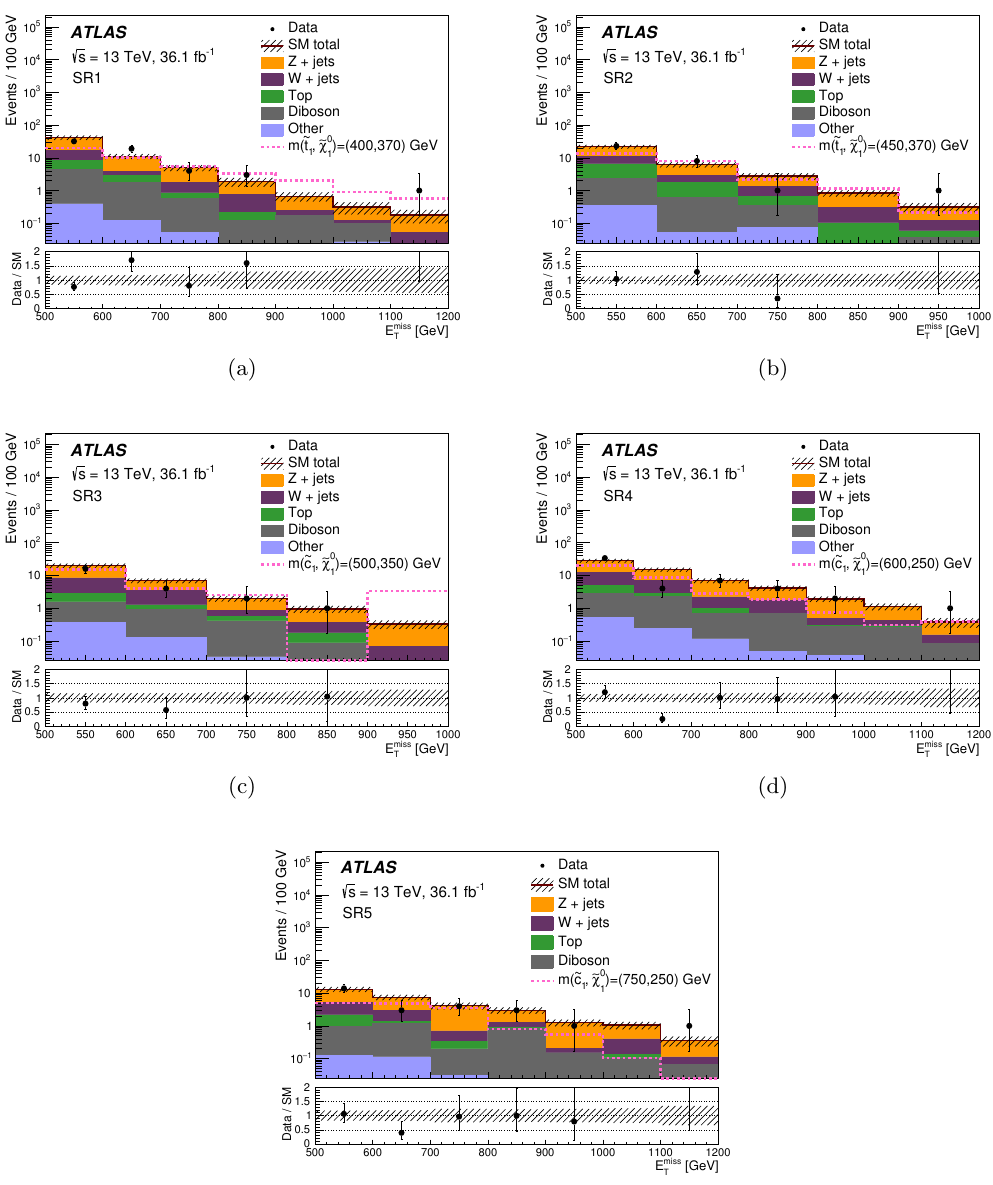
Figure 5 . Comparison between data and expectation after the background-only (cid:12)t for the E miss distribution (a) in SR1, (b) in SR2, (c) in SR3, (d) in SR4, and (e) in SR5. The shaded band indicates the detector-related systematic uncertainties and the statistical uncertainties of the MC samples, while the error bars on the data points indicate the data’s statistical uncertainty. The (cid:12)nal bin in each histogram includes the over(cid:13)ow. The lower panel shows the ratio of the data to the SM prediction after the background-only (cid:12)t. In each plot, the distribution is also shown for a representative signal